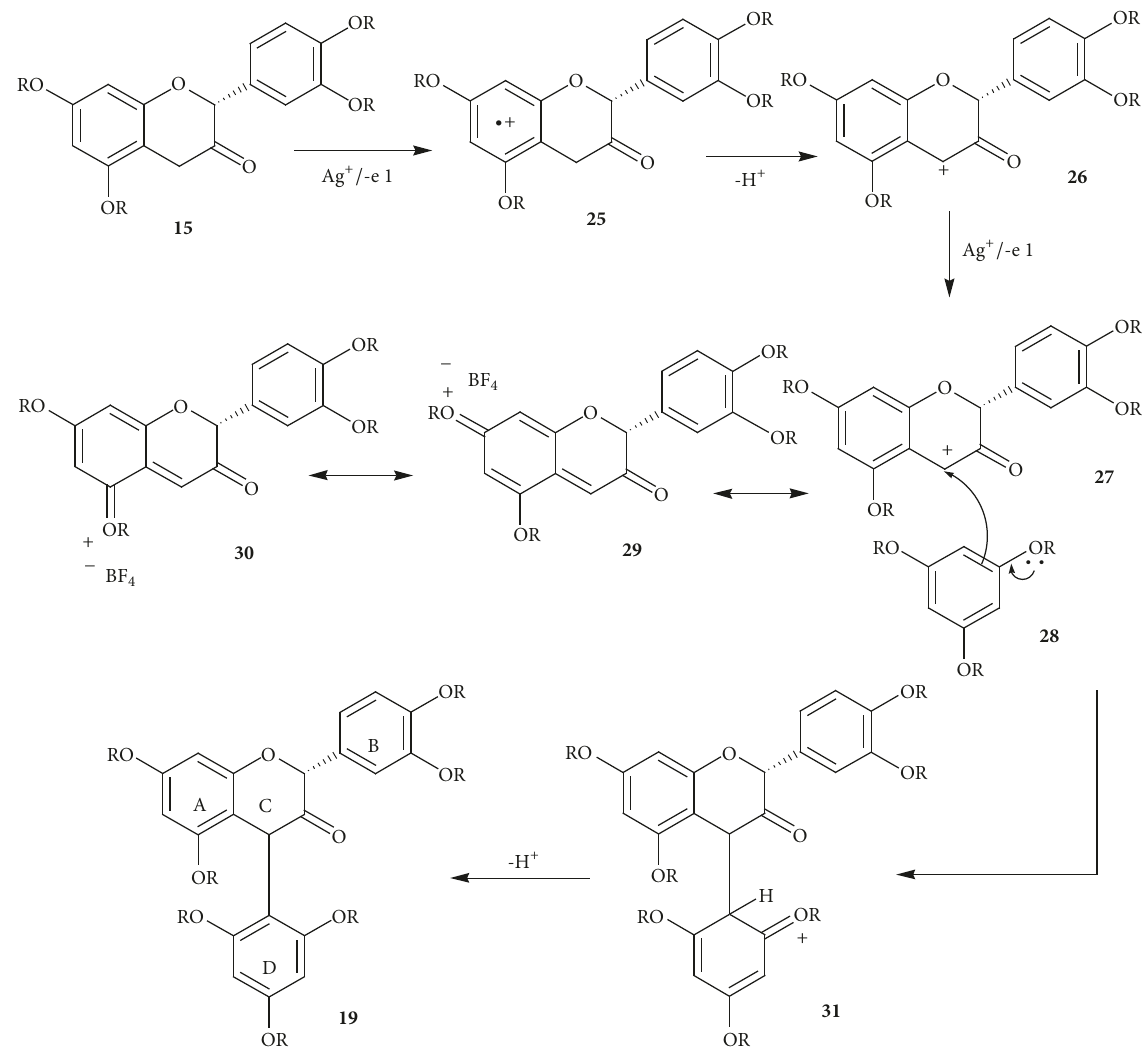
Scheme 7: Proposed mechanism for the formation of 19